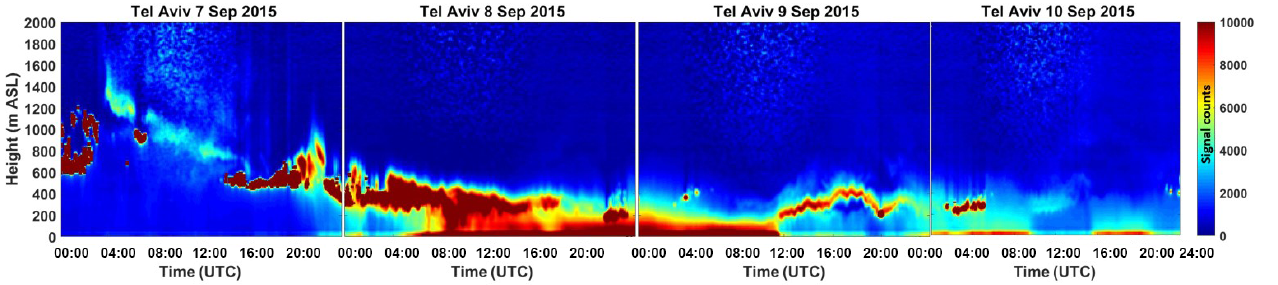
Figure 8. Tel Aviv ceilometer signal counts plots for 7–10 September 2015. The y axis is the height from site deployment to 2000ma.s.l., the x axis is the time in UTC, and the signal count scale ranges between 0 and 10000.